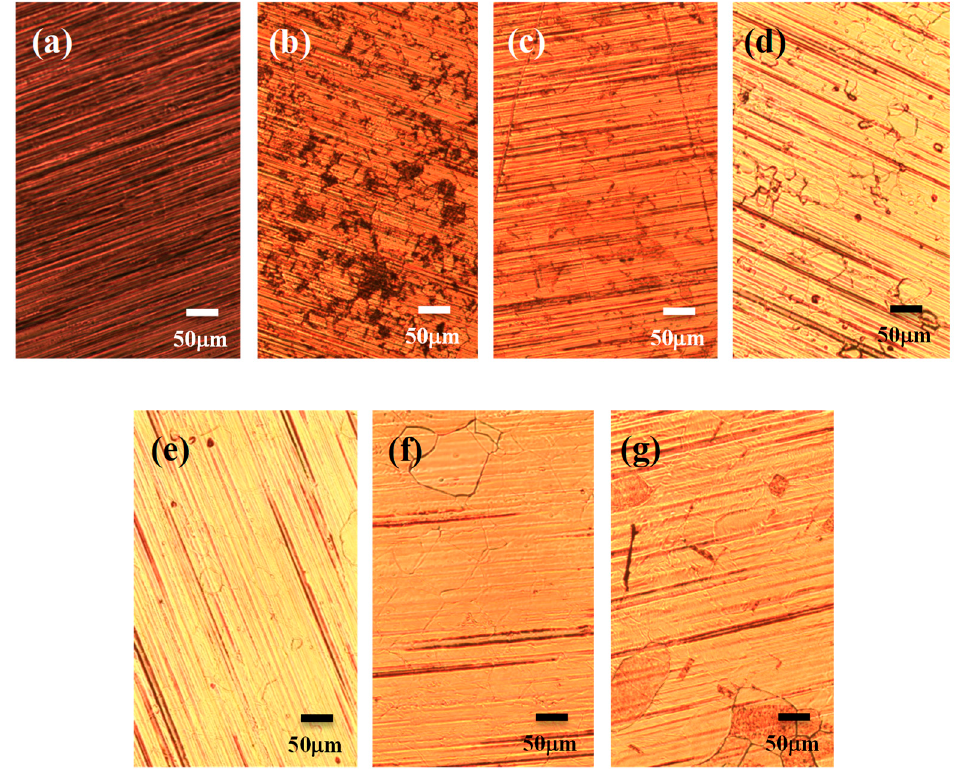
Figure 1. Optical micrographs of the ( a ) bare copper foil, and graphene grown in the atmosphere of 20 sccm Ar carrying methanol and 15 sccm H 2 , for 30 min. with temperatures of ( b ) 500 °C, ( c ) 700 °C, ( d ) 800 °C, ( e ) 850 °C, ( f ) 900 °C, ( g ) 950 °C, respectively.